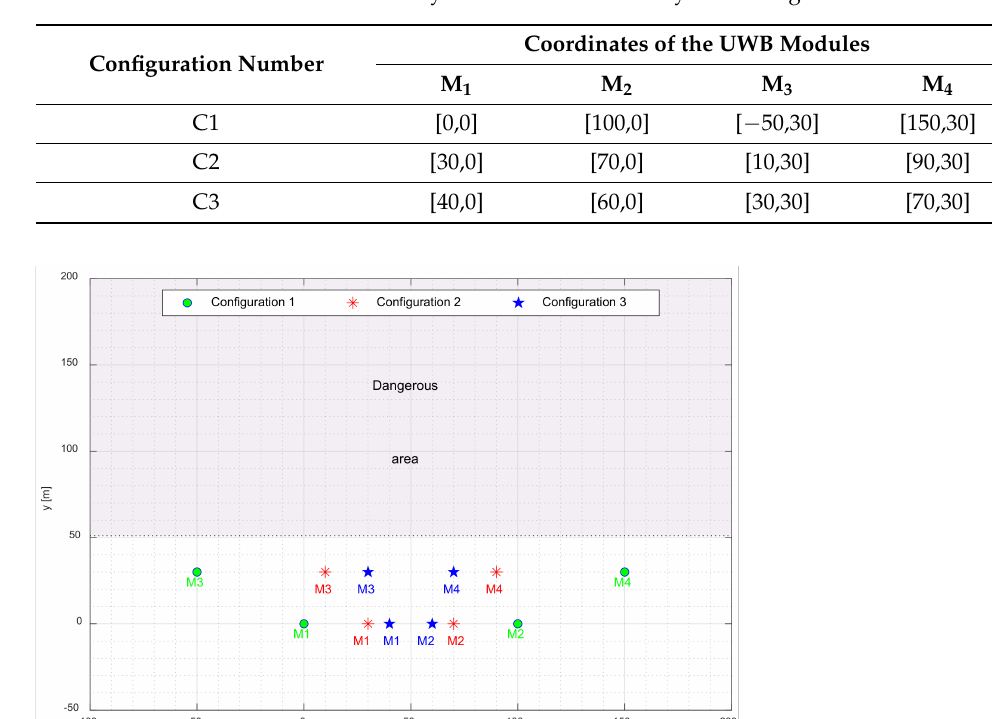
Table 1. Locations of the UWB stationary modules for different system configurations.